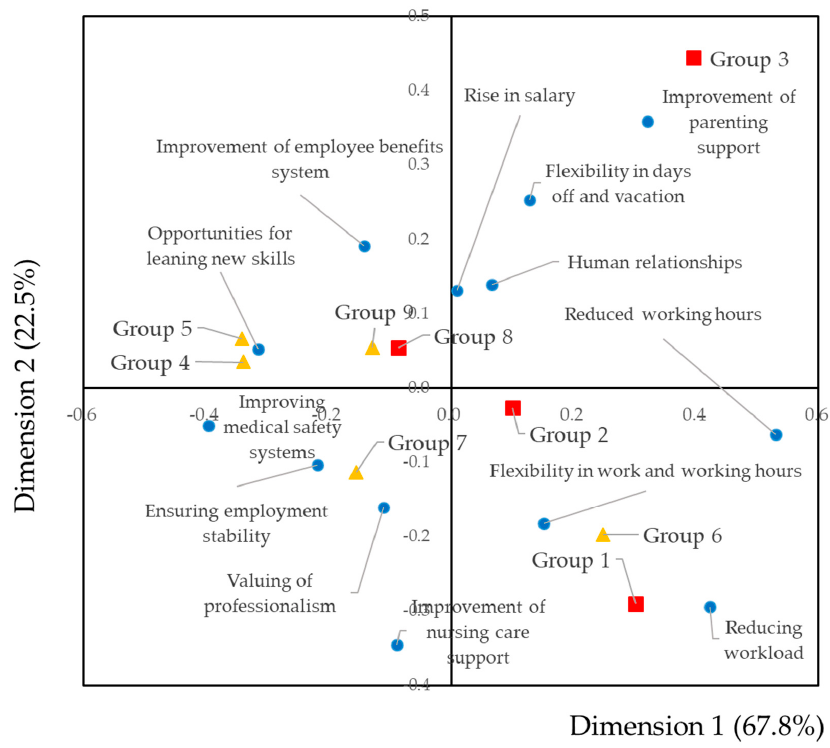
Figure 3. Biplot of groups by daily tasks and requests for improvement of the working environment. The results of the corresponding analysis are graphically illustrated as a biplot. Items with similar characteristics are plotted closely and the smaller the angle in relation to a given point, the stronger the relation. Blue circles indicate requested improvements of the working conditions. Red squares indicate groups in which the proportion of full-time workers is high. Yellow triangles indicate groups in which the proportion of part-time workers is high. The contribution ratio of dimension 1 was 67.8% and for dimension 2 it was